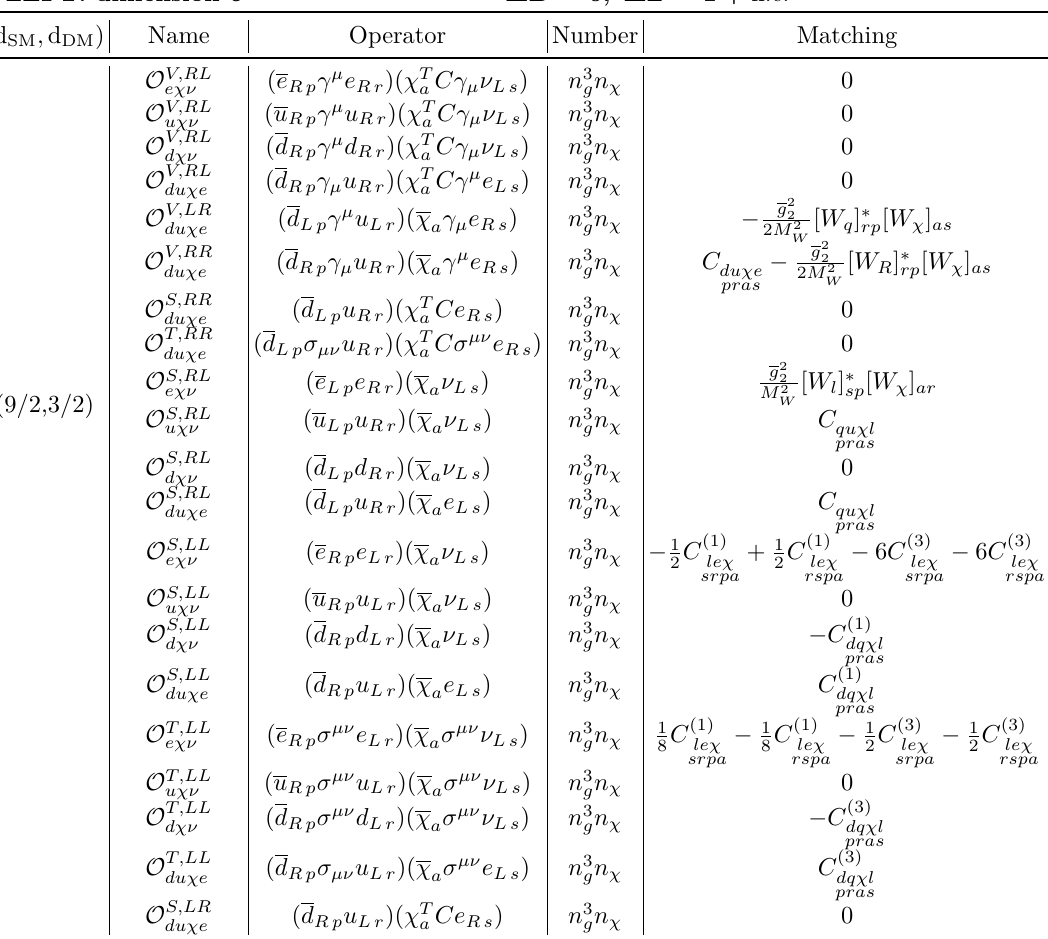
Table 28 . Dimension-six ∆ B = 0 , ∆ L = 1 operators in DLEFT, part 2. The first column gives the dimensions of the SM and DM part of the operator, the fourth column is the number of operators, and the fifth column is the additional matching contribution at the EW scale.